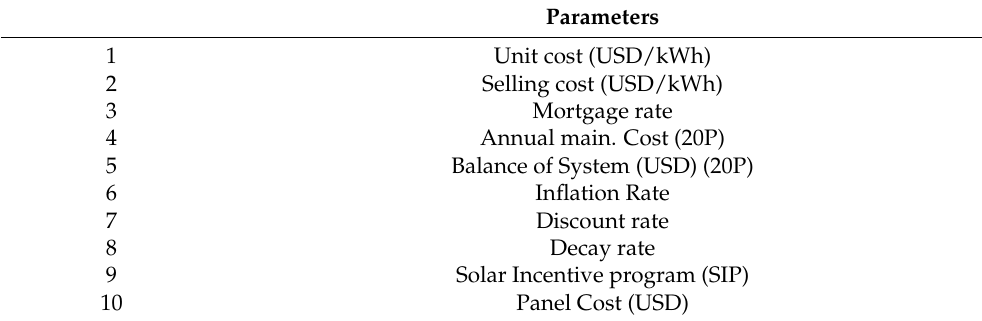
Table 3. Variables applied to the